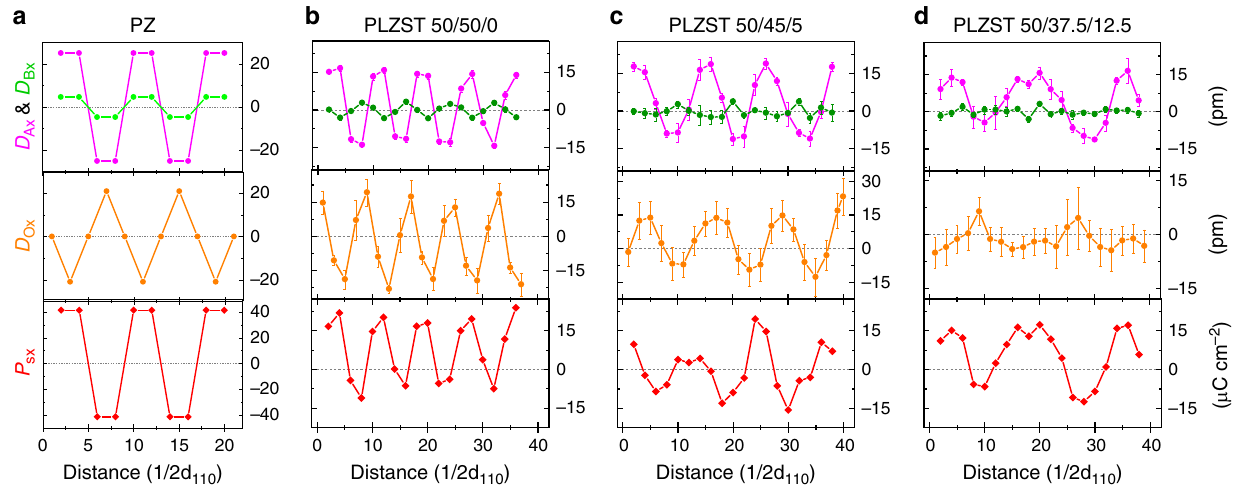
Fig. 4 Quantitative analysis of coupling between O-anions displacement and A/B-cations displacement. a – d The horizontal component of atomic displacement and spontaneous polarization for each atomic row is plotted as a function of distance along the y-direction for PbZrO 3 and PLZST system. The purple, green, orange, and red pro fi les represent the A-cations, B-cations, O-anions, and P s , respectively. The value of these pro fi les are calculated from the Fig. 3a – d, where the displacement are de fi ned as negative value when it aligns to the left. The corresponding pro fi les for vertical component are presented in Supplementary Fig. 8. The error bars represent the standard deviation measured from the experimental